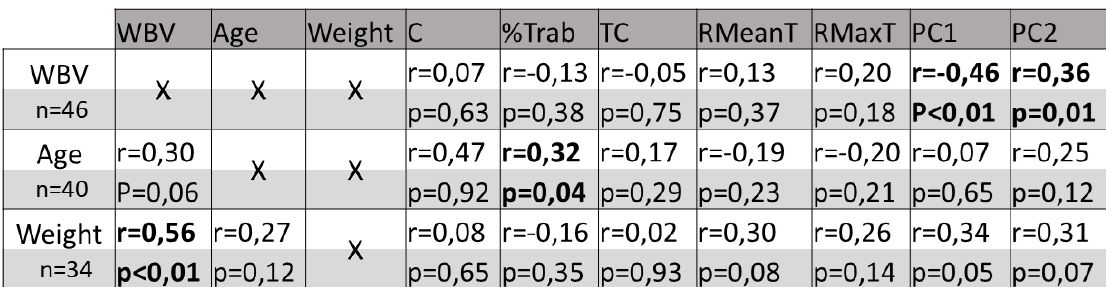
Table 2: Values obtained for tests of the effect of total volume, age, and weight on the different parameters and the PCA axes. r: correlation coefficient; p: p-value of the linear regression model; WBV: whole bone volume; RMeanT, mean relative cortical thickness; RMaxT, maximum relative cortical thickness; PC1, PC2: position of individuals on the first two axes of the